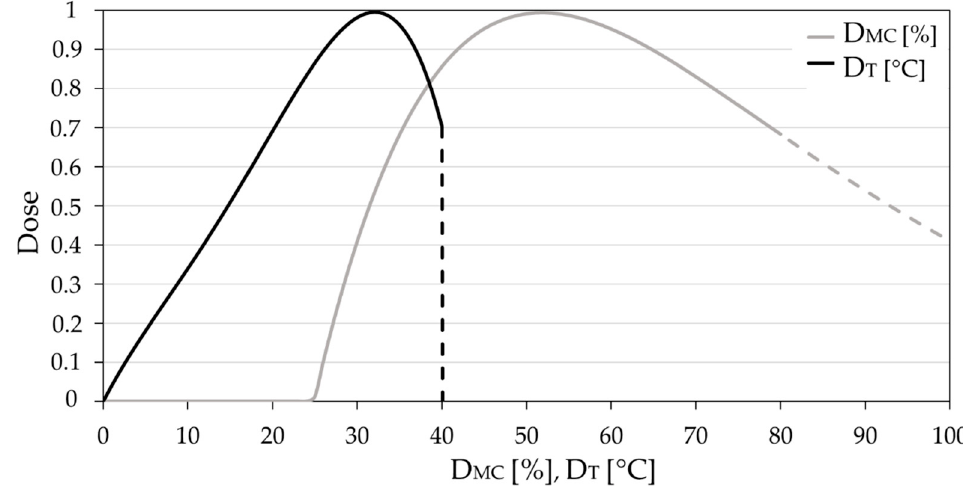
Figure 2. Relationship between mean wood moisture content (MC in %) and the daily moisture-induced dose component, and between mean wood temperature ( T in °C) and the daily temperature-induced dose component. Dashed lines mean that curve progression is uncertain due to a lack of data beyond zones represented by solid lines. Graph adapted from Brischke et al. [24] .